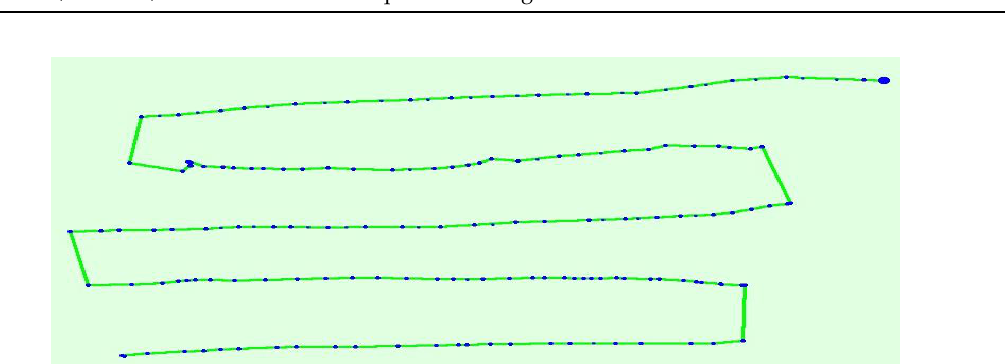
Figure 8. UAV flight line to obtain nadir images. Lines represent the drone flight path; dots represent image capture positions on the flight path.